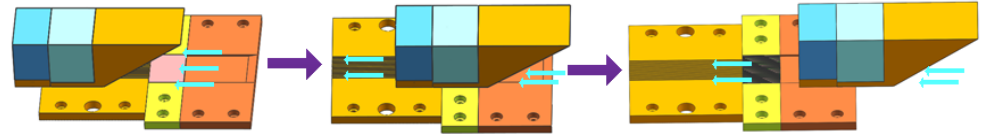
Figure 11. Schematic diagram of ECB process.